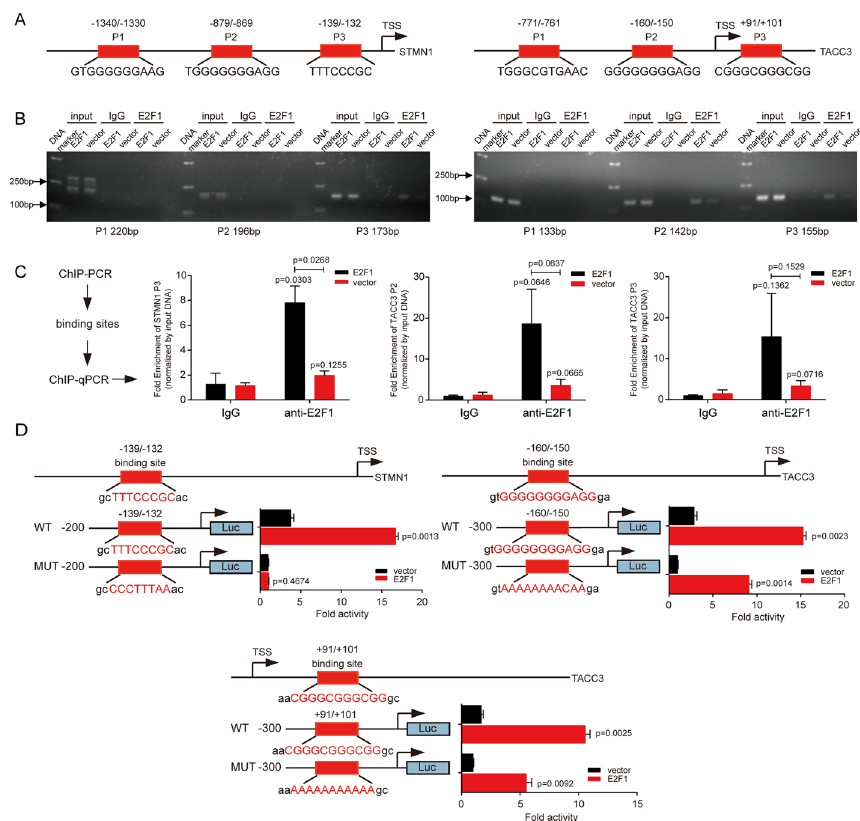
Fig. 3 E2F1 transactivates stathmin1 and TACC3 in CRC cells. A Schematic representations of the promoter regions of human STMN1 and TACC3 . The predicted E2F1 binding sites are indicated. B Agarose gel electrophoresis of ChIP-PCR products in the input, IgG, and ChIP groups, showing that E2F1